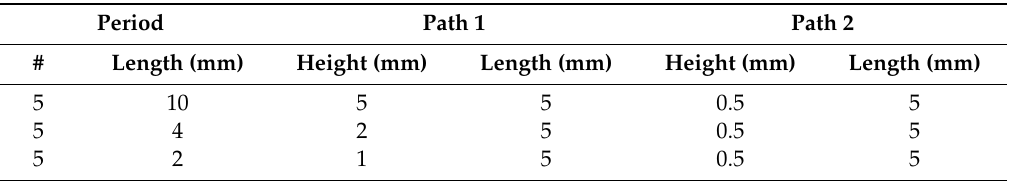
Figure 2. Assembly diagram for contact variation. Table 1. Grid feature: Square profile.